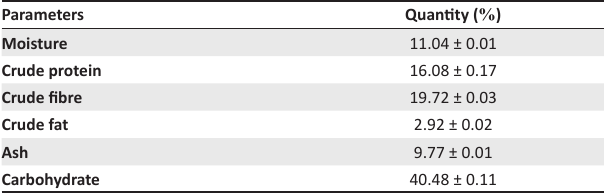
TABLE 1: Proximate composition of Crescentia cujete leaves on dry basis.